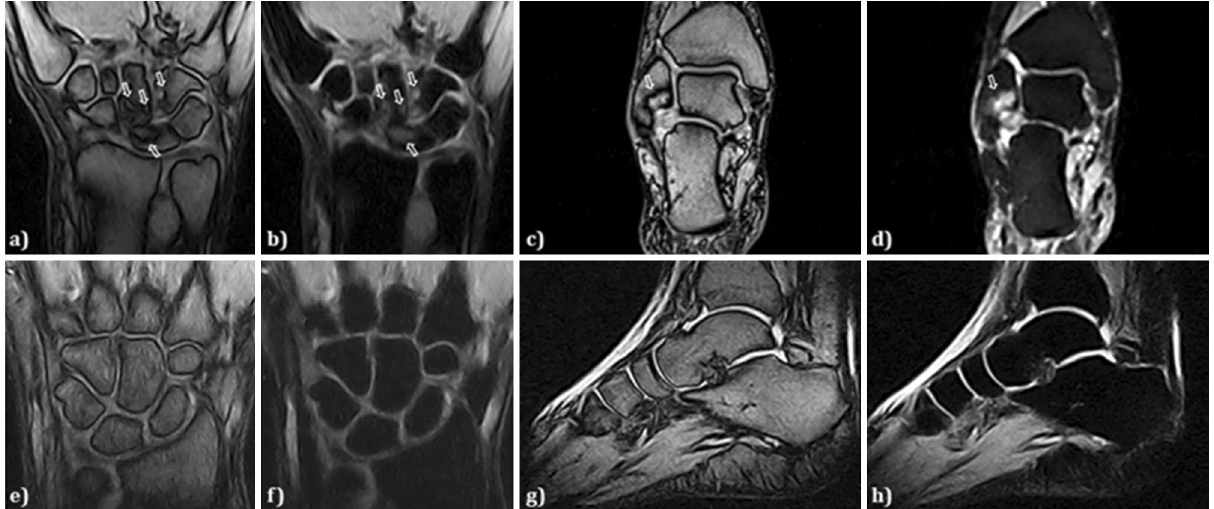
Figure 1. Synovitis, bone oedema, and bone erosions, as common MRI findings on wrists and ankles in AOSD. In panels ( a ) and ( b ), T1-weighted and T2-STIR images of coronal sections on wrist are shown, respectively, detailing a mild to moderate proliferative synovitis, as thickening of the synovial membrane, with low to intermediate signal intensity on T1-weighted images and intermediate to high signal intensity on T2-STIR images (arrows). Bone oedema and bone erosions are also shown, which overlapped the locations (arrows). In panel ( c ) and ( d ), T1-weighted and T2-STIR images of coronal sections on ankle are shown, respectively, detailing a mild to moderate proliferative synovitis, with low to intermediate signal intensity on T1-weighted images and intermediate to high signal intensity on T2-STIR images (arrows). Bone oedema and bone erosion are also shown, which overlapped the locations (arrows). In panels ( e ) and ( f ) T1-weighted and T2-fat saturated images of coronal sections on wrist are shown, respectively, detailing no pathologic findings. In panels ( c ) and ( d ), T1-weighted and T2-STIR images of sagittal sections on ankle are shown, respectively, detailing no pathologic